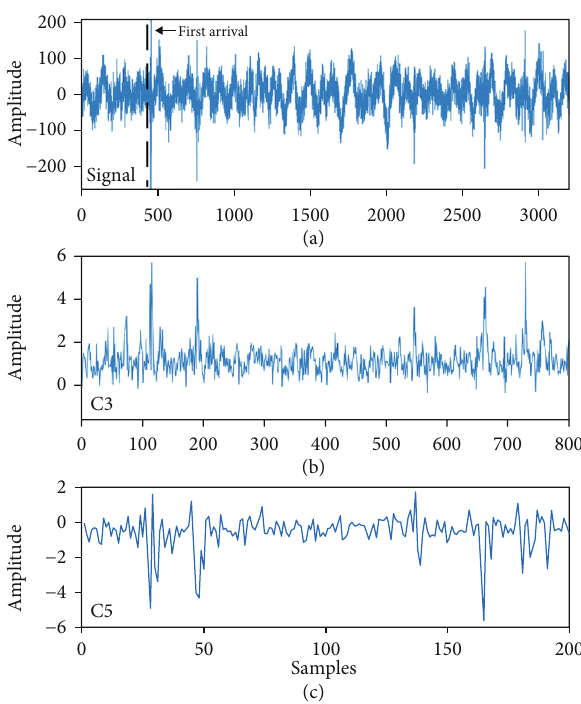
Figure 21: The sixth trace signal of the actual microseismic record pro fi le shown in Figure 20 and its intermediate features extracted by the UNet++. (a) The sixth trace signal of the actual microseismic record pro fi le shown in Figure 20. (b) Intermediate features of the signal extracted by C3 layer. (c) Intermediate features of the signal extracted by C5 layer.